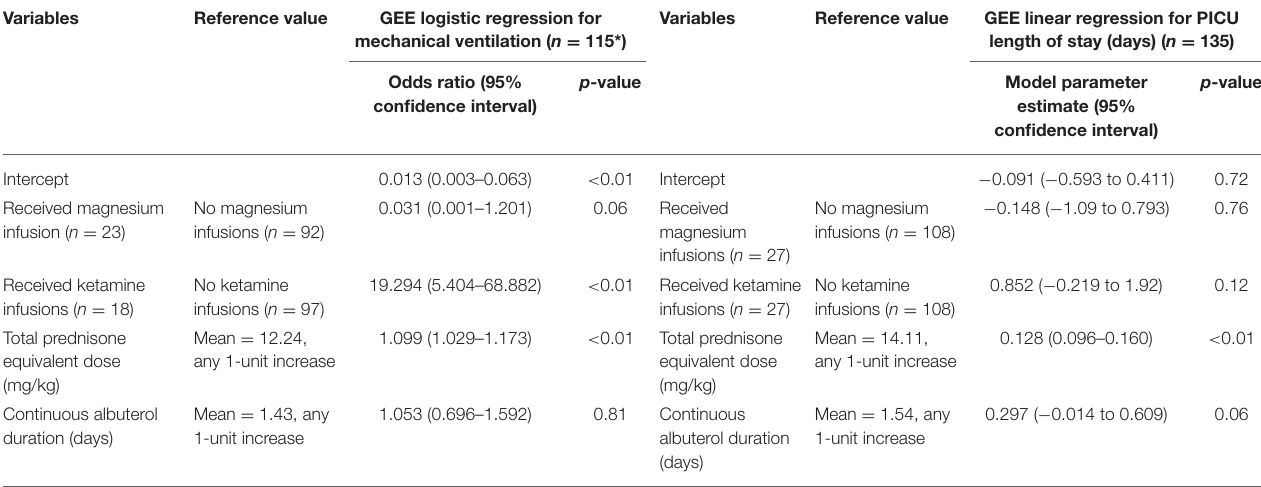
TABLE 5 | Logistic and linear regression models looking at mechanical ventilation requirement and PICU LOS.